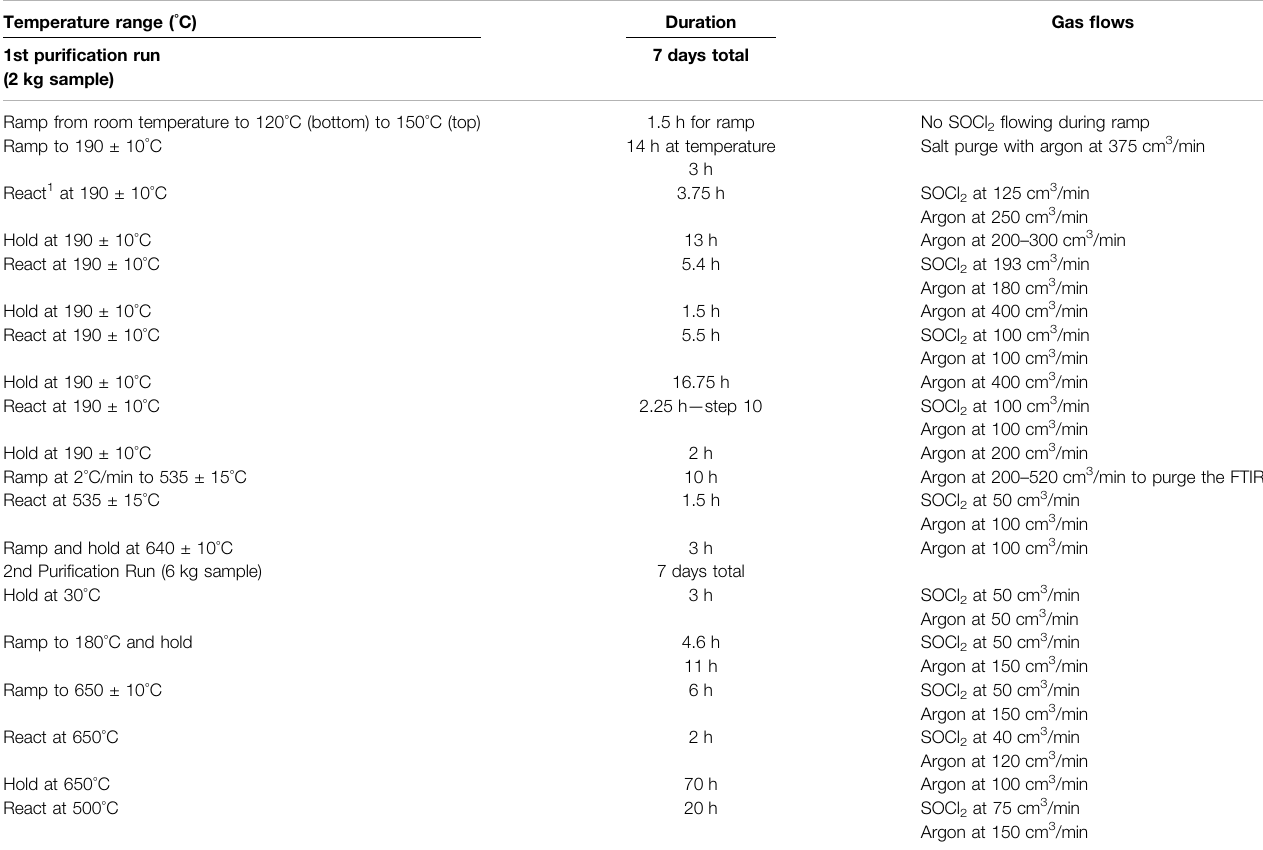
TABLE 1 | Test matrix for puri fi cation of